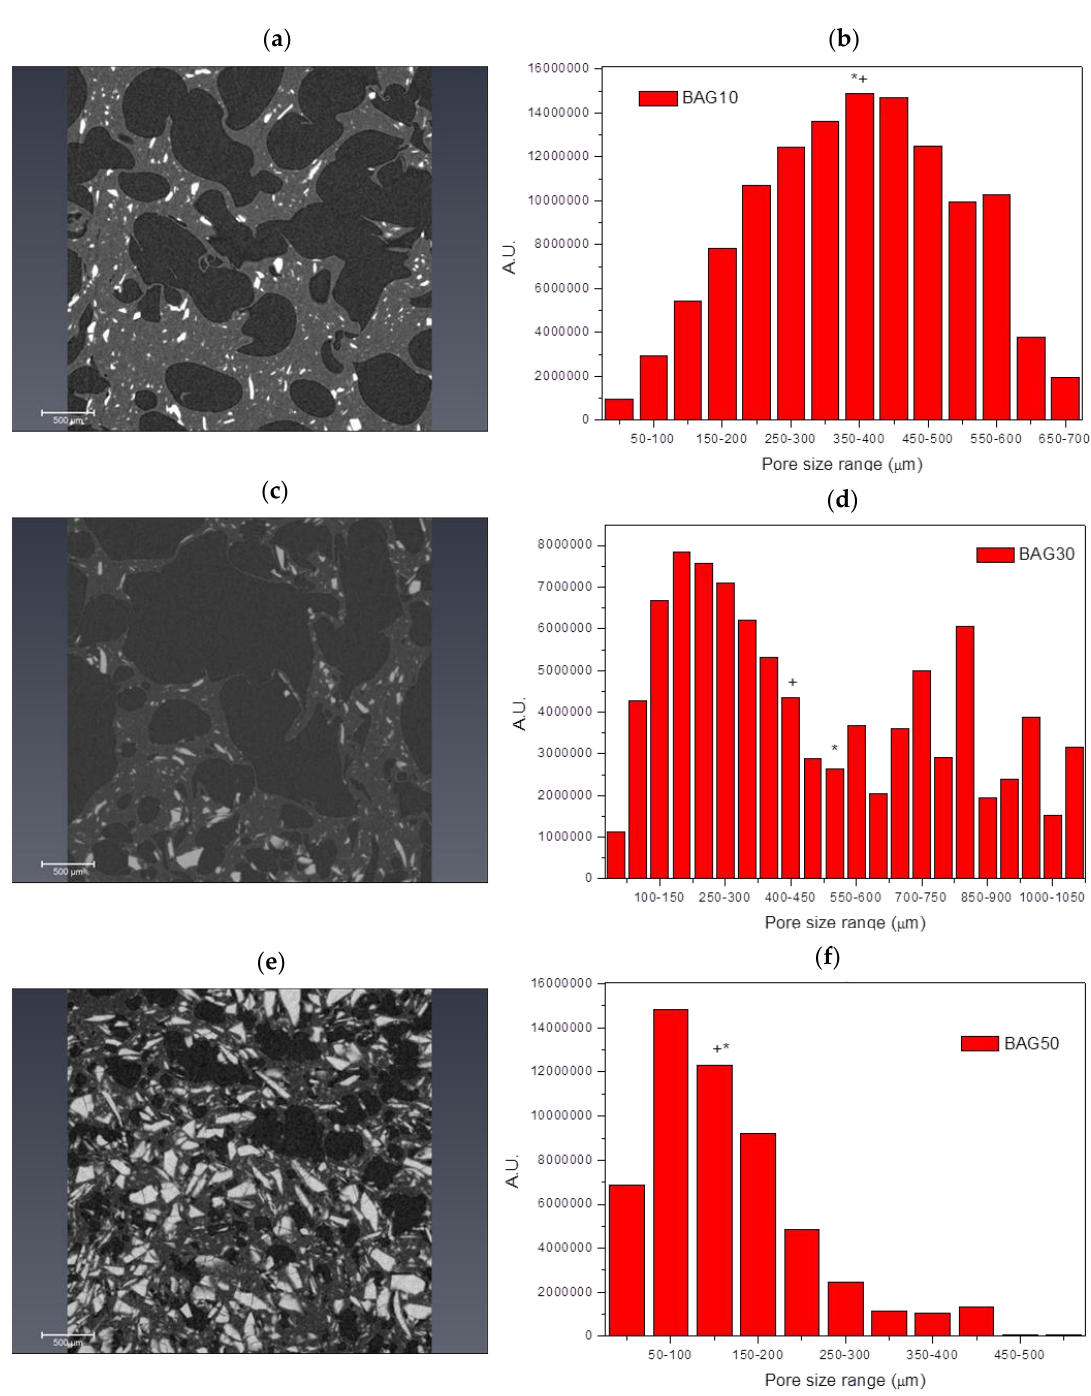
Figure 2. Microcomputational tomography image and pore size distribution of different bioactive glass Figure 2: Microcomputational tomography image and pore size distribution of scaffolds BAG10 (BAG) scaffolds by wt %: BAG10 ( a , b ); BAG30 ( c , d ) and BAG50 ( e , f ). (+ and * denote the average and (a and b), BAG30 (c and d) and BAG50 (e and f). median pore size,